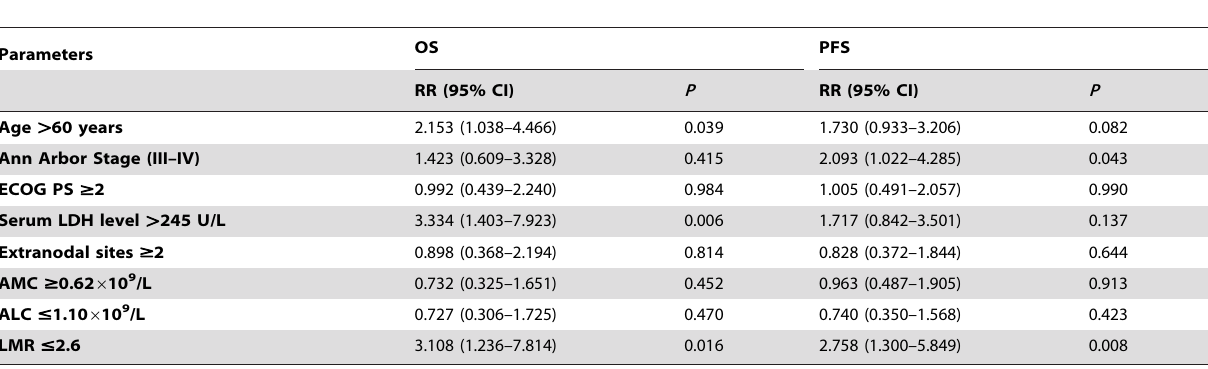
Table 2. Multivariate analysis of prognostic factors for survival in testing set.